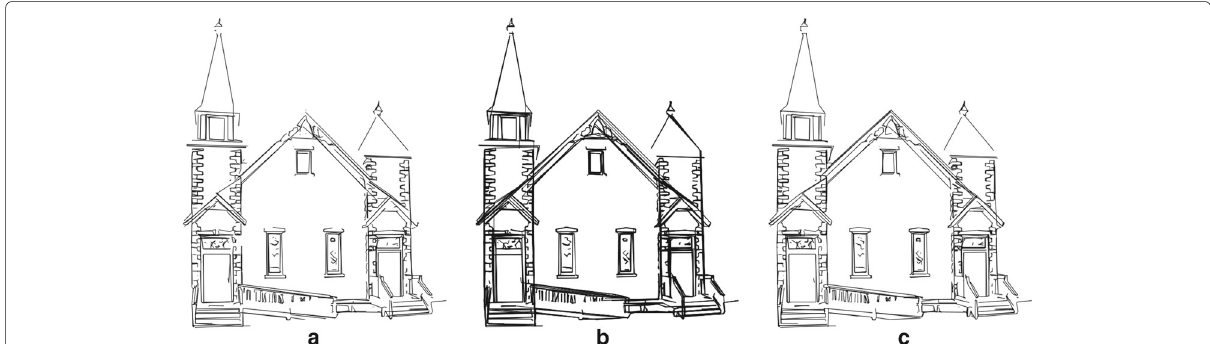
Fig. 8 Results of segment detection of the image in Fig. 7a. a Detected segments without considering segment endpoints of neighboring lines. b Detectedsegmentswithoutnon-maximumsuppression. c Detectedsegmentsusingendpointsofneighboringlinesandnon-maximumsuppression